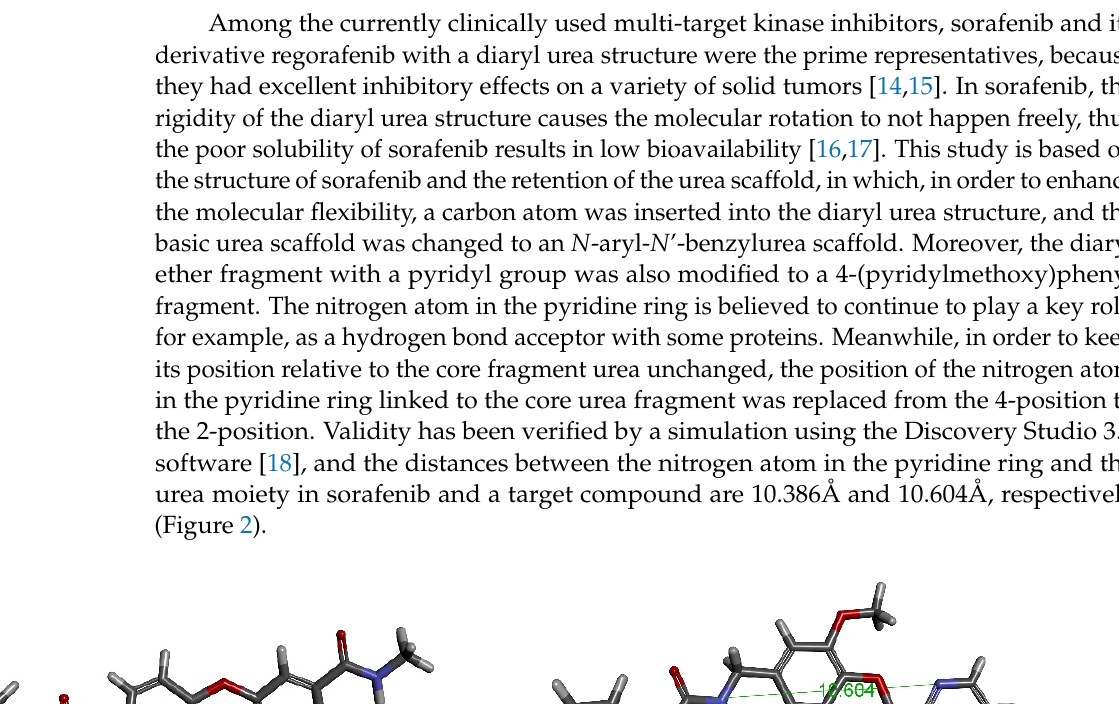
Figure 1. The application of urea and its isosteres in anticancer drugs.